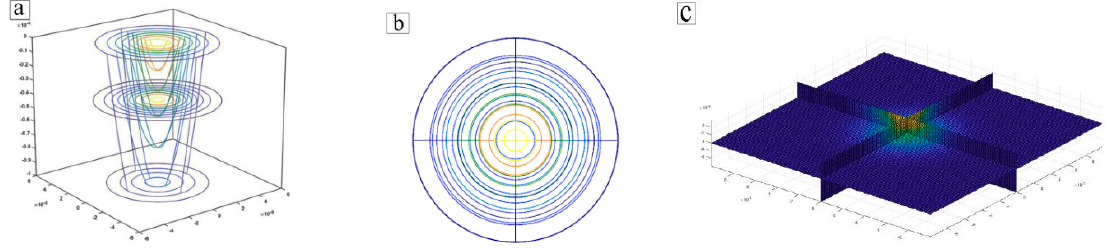
Figure 1. Heat source model. ( a ) The distribution of heat source energy. ( b ) The plane distribution of the heat source. ( c ) A three-dimensional slice of the heat source.